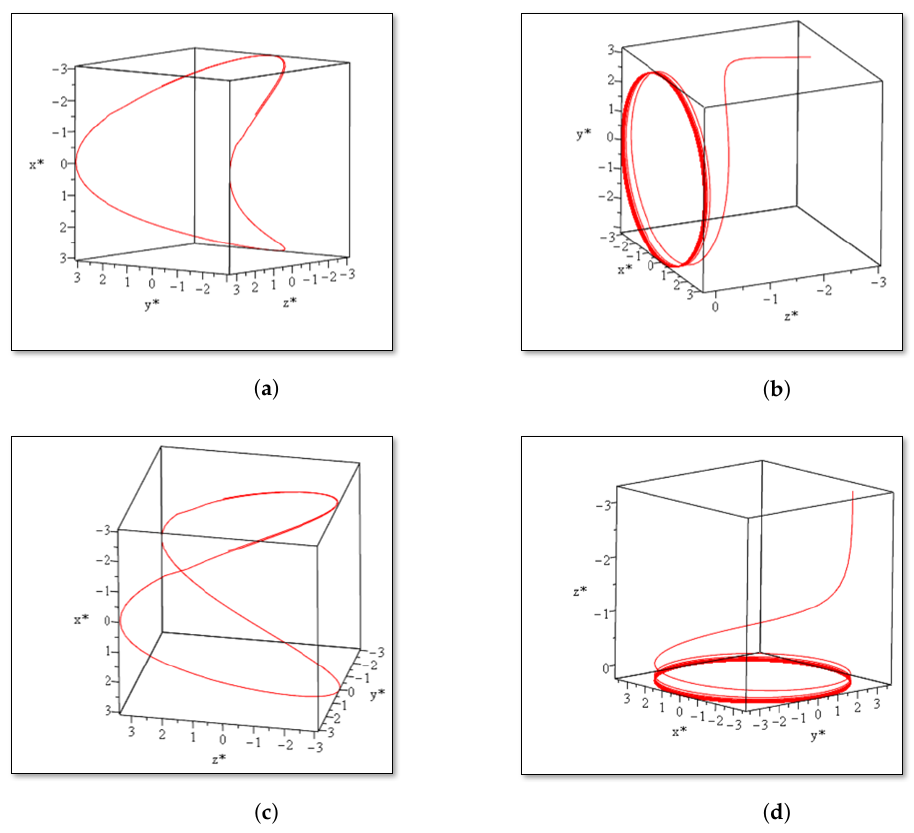
Figure 1. Example of the periodic orbit in a cube associated with Equation (15). ( a ) Phase portrait of saddle-type orbit ( c 3 = 1280). ( b ) Two-dimensional set-limit cycle for c 3 → ∞ . ( c ) Visualization of Figure 1a from rotated angle. ( d ) Visualization of Figure 1b from rotated